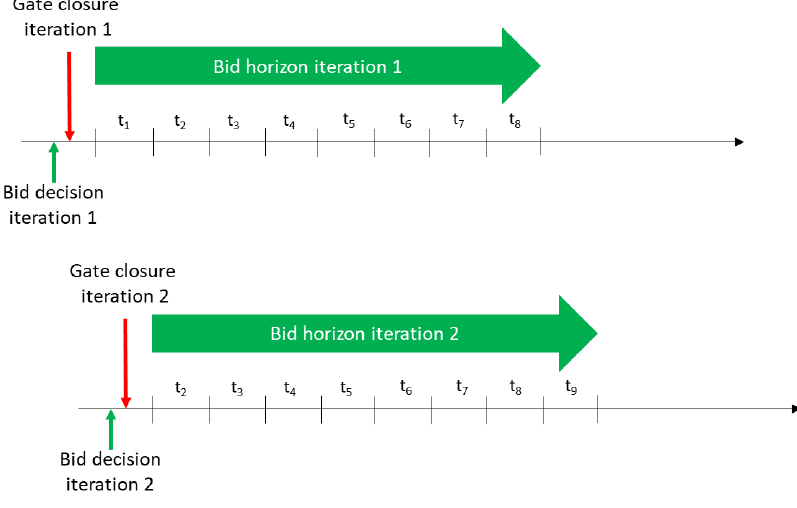
Figure 3. Iterative trading process with rolling horizon.